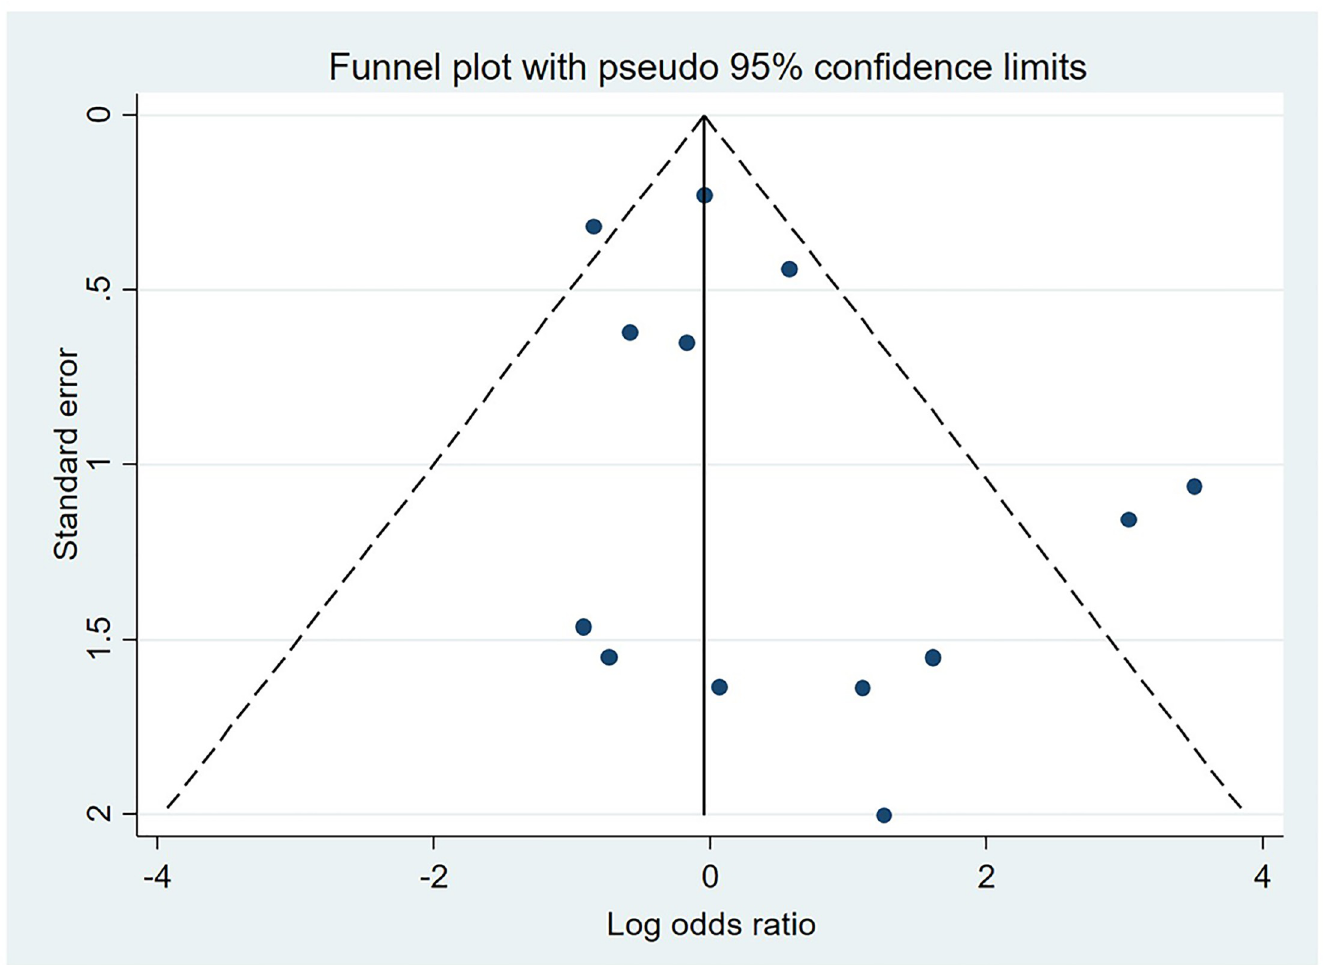
Fig 6. Funnel plot for studies included in the analysis of the relationship between nuchal cord and stillbirth.